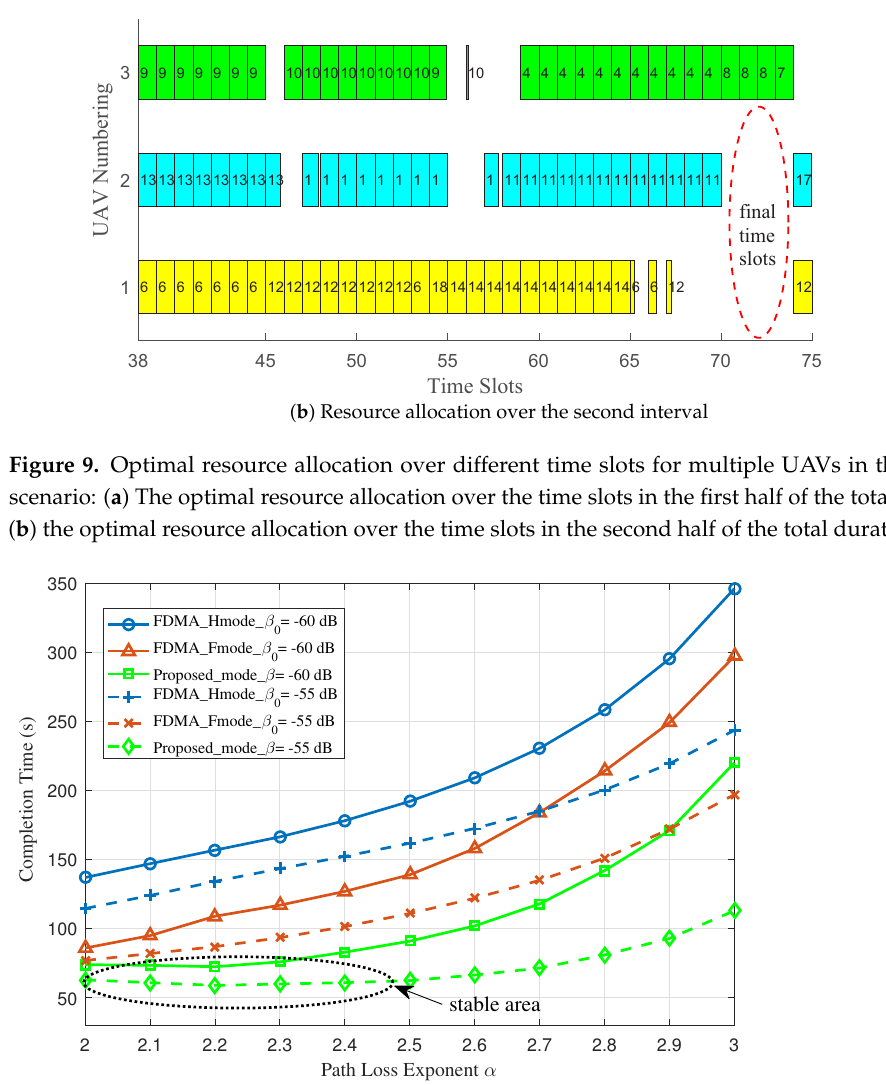
Figure 10. The completion time for network data collection versus the path loss exponent under different